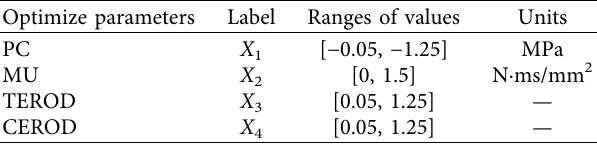
Figure 4: Experimental displacement-time data of the center of the flat plate. Table 5: The value range of the four parameters.